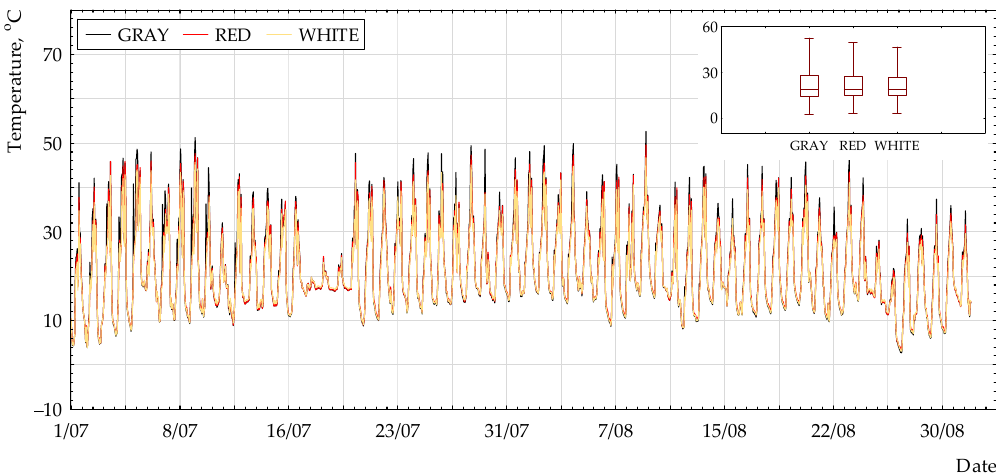
Figure 3. Surface temperature (N_45°) for the period of 1 September to 31 October 2017.